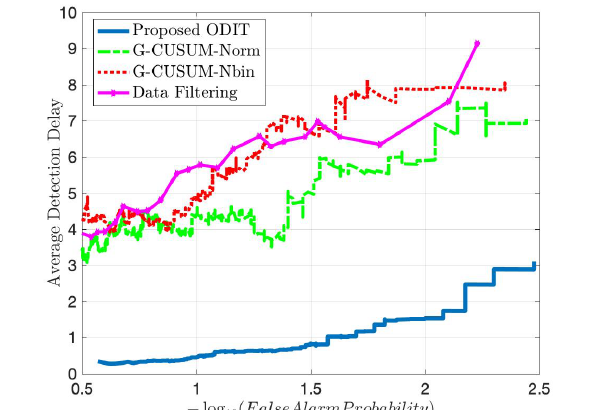
Figure 12. Comparison in terms of quick and accurate detection for an average DDoS attack magni- tude of 1.5 times the nominal mean data rate between the proposed method, two idealized G-CUSUM variants which know the exact attack magnitude, and the data filtering